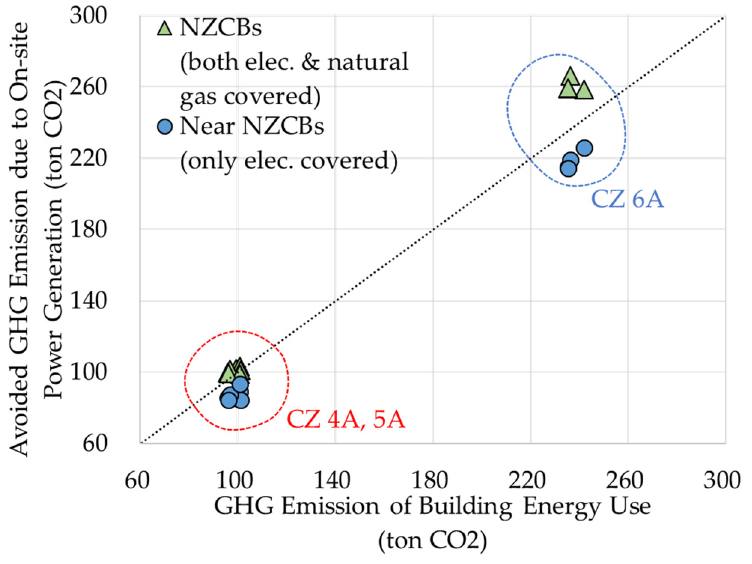
Figure 14. GHG emission balance for NZCB designs in climate zones (CZ).